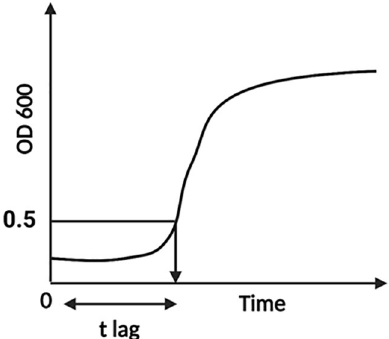
Figure 1. Graphic description of the determination of t lag from the growth curves used in this study. The 0.5- intercept represents the net increase in OD 600, i.e. , the value subtracted from the optical density (OD) at time zero.